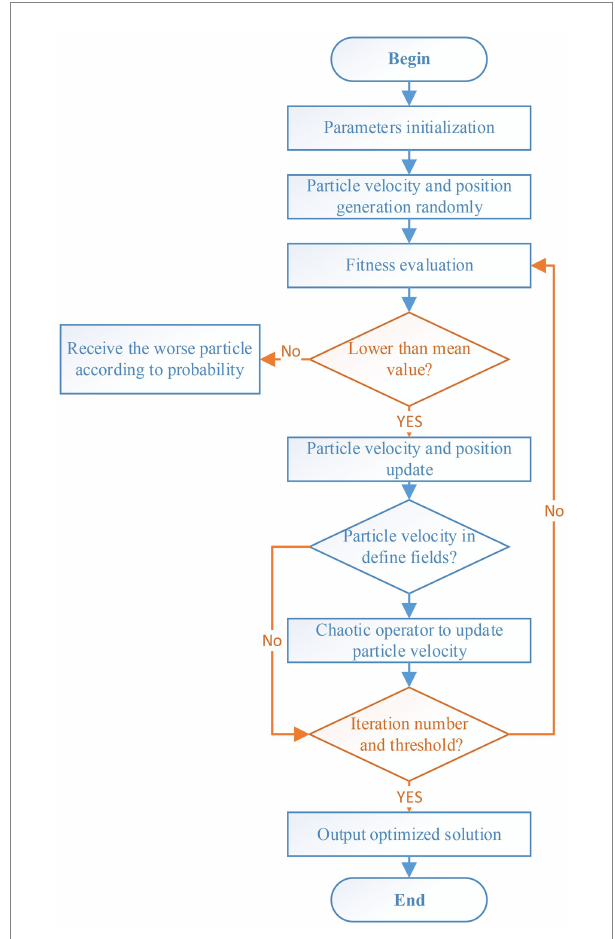
FIGURE 3 The flow chart of the model optimization using the